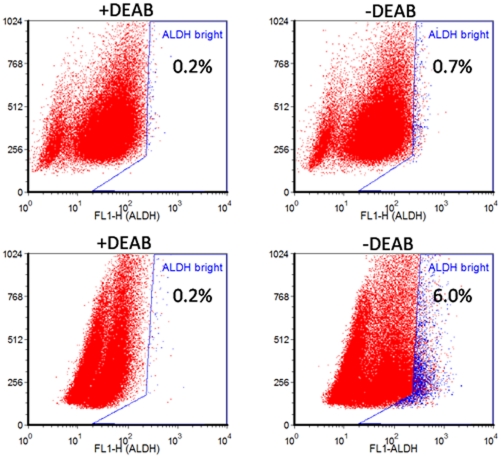
Showed the presence of PE e/10 percentage of ALDHbr cells which are increased upon culturing in spheroid conditions, providing information about the presence of putative CSC in MPE primary cultures.